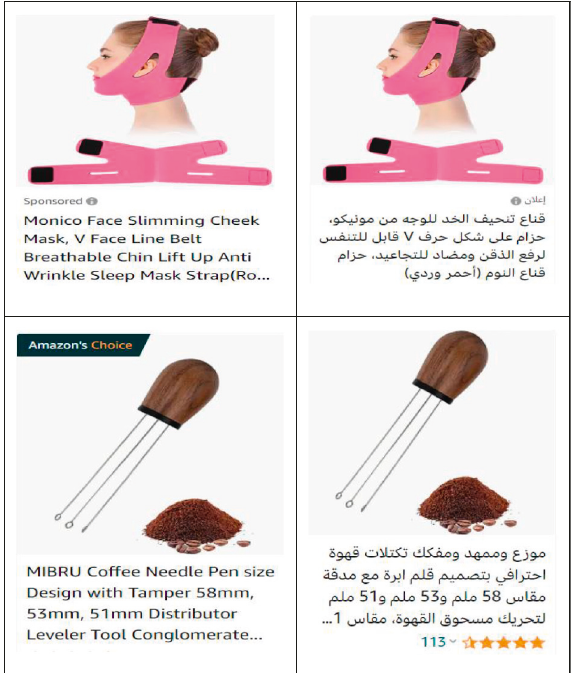
Figure 17: Examples of translated promotional texts attached to items on